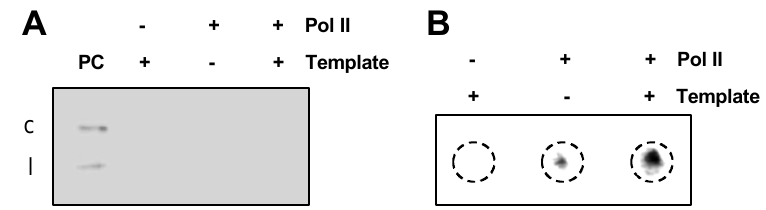
Figure 2. The activity of purified Pol II on DNA templates. The purified Pol II cannot generate specific RNA products from the p35S::RZ-PSTVd plasmid ( A ) but did possess nucleotide incorporating activity as shown in a dot blot ( B ). PC, the mixture of circular and linear PSTVd RNA served as the positive control. c, circular PSTVd. l, linear PSTVd.